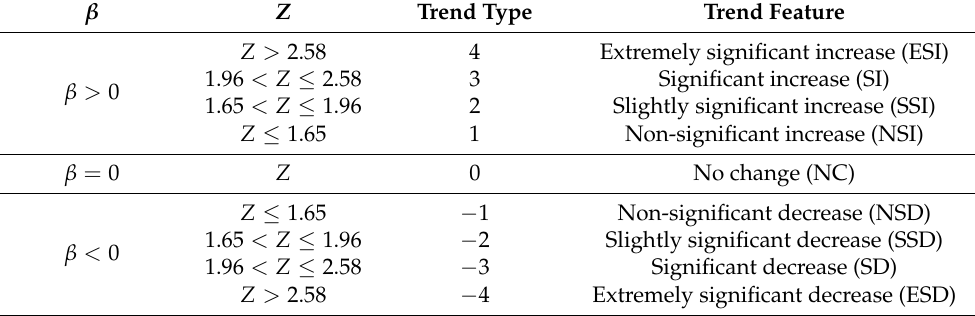
Table 1. MK test trend